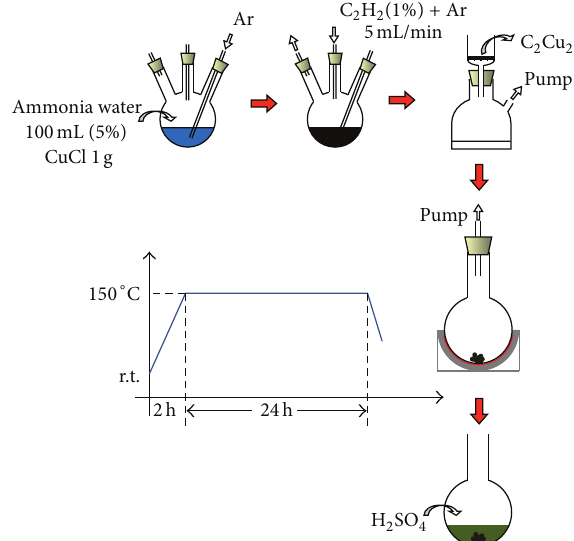
Figure 1: Illustration of the method used to prepare amorphous carbon under 150 ∘ C. Copper acetylide precursor was prepared via thereactionofCuClandC 2 H 2 underNH 3 water.Thentheprecursor was separated by suction filtration and annealed at 150 ∘ C. Finally, sulfuric acid treatment was carried out for eliminating